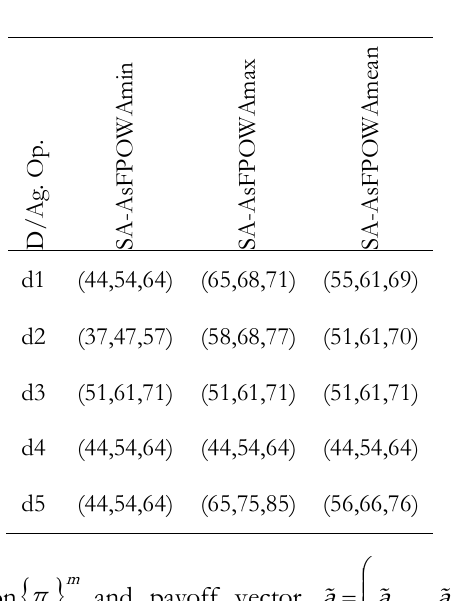
Table 6. Aggregation